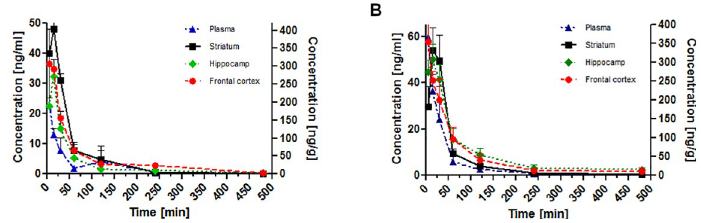
Fig 6. Concentration–time profiles of AZ-853 (A) and AZ-861 (B) in mouse plasma and different brain regions. AZ-853 administered i . p . at the dose of 0.625 mg/kg and AZ-861 administered i . p . at the dose of 1.25 mg/kg. Concentrations of the tested compounds in plasma and brain are expressed as ng/mL and ng/g, respectively. Data represent mean ± SEM, n = 6 mice per group per time point.